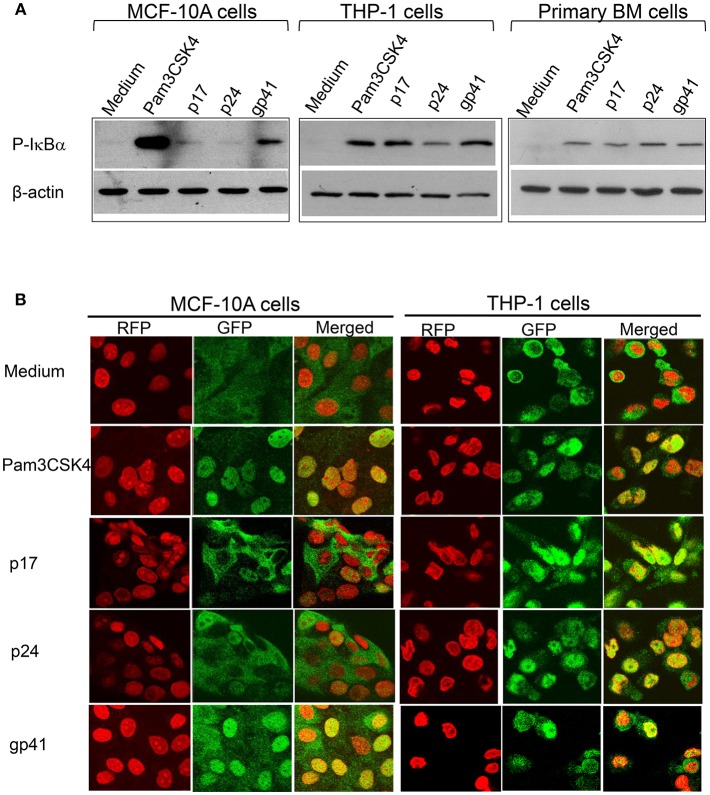
HIV-1 proteins lead to NF-κBα activation (A) Western blot analysis of the cell lysates extracted from MCF-10A, THP-1, and primary BM cells treated with HIV-1 proteins and detected with an antibody against the active NF-κBα subunit, phospho(P)-IκBα, with anti β-actin used as the loading control on the same membranes (B) Confocal microscopy of HIV-treated MCF-10A and THP-1 cells fixed and stained with an anti- NF-κBα subunit p65 antibody and visualized with a second antibody, anti-rabbit-IgG-alexa488 (GFP; green), p65 was translocated upon activation into the nuclei (RFP; red with propidium iodide staining) displayed in yellow (Merged).